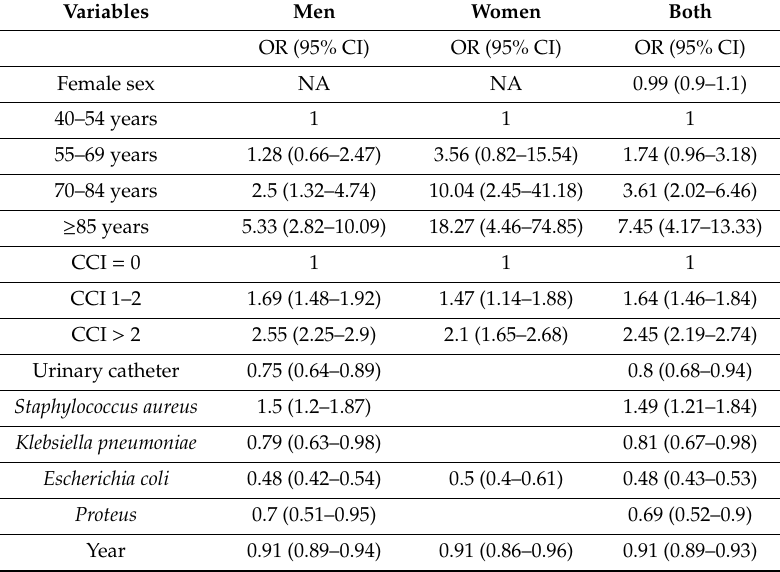
Table 3. Variables associated with in-hospital mortality in hospital admissions of COPD patients with a principal diagnosis of urinary tract infection according to sex in Spain (2001–2018).